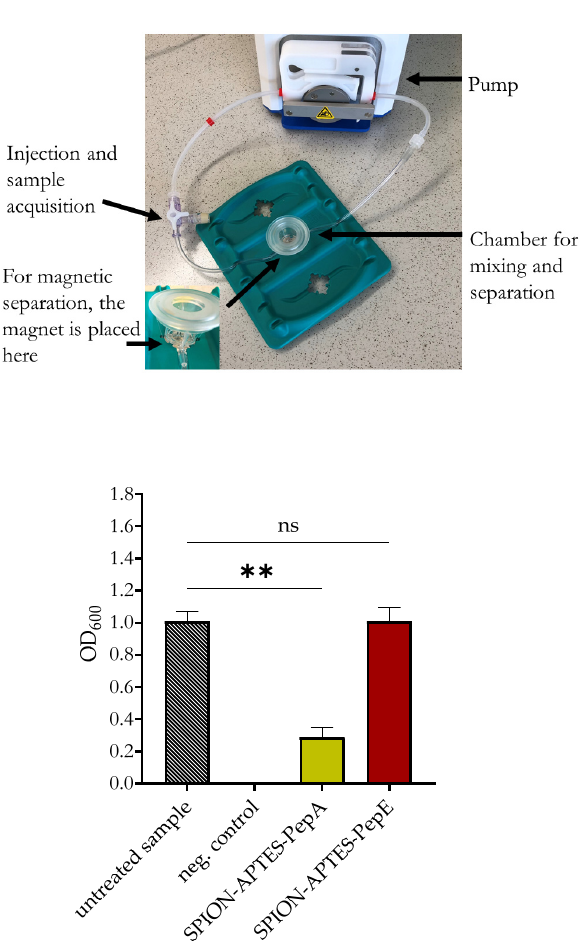
Figure 6. Above: Separation device for flow experiments. Below: Removal of S. aureus under flow conditions (10 mL/min, see also Figure A1) in Ringer solution using SPION-APTES-PepA and SPION-APTES-PepE at a concentration of 300 µg Fe/mL. The results shown represent the mean values with standard deviations of three independent experiments. Statistical testing was performed between untreated and treated samples using a Kruskal – Wallis test with a post hoc Dunn’s test; ** p ≤ 0.05. p values above 0.05 were considered non-significant (ns).